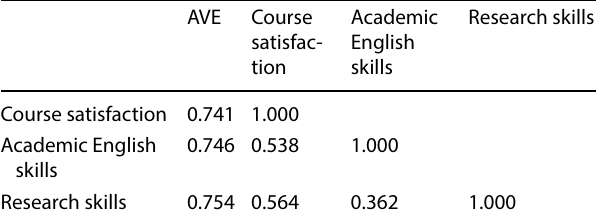
Table 8 The correlation coefficient and AVE matrix of the potential construct AVE